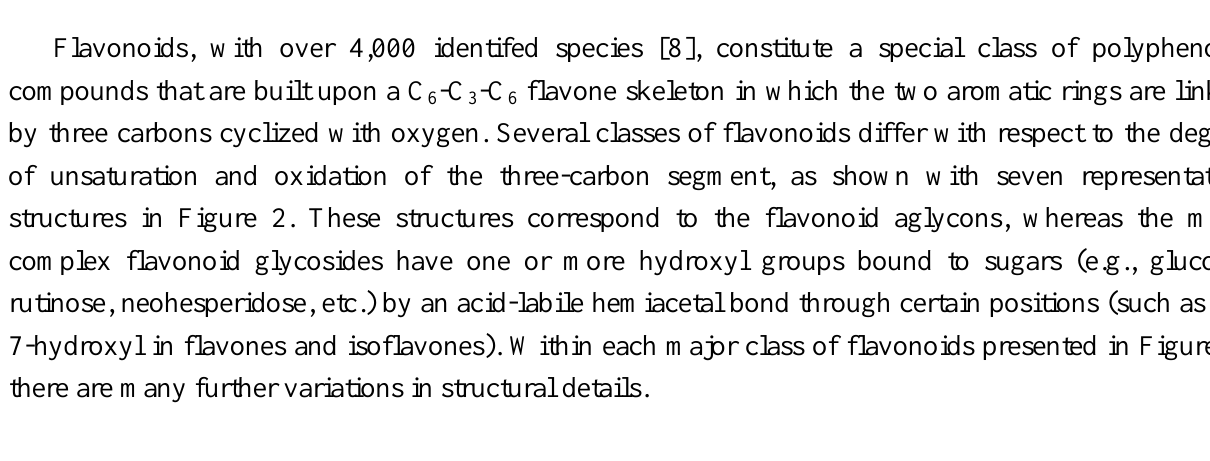
Figure 2. Representative classes of flavonoids